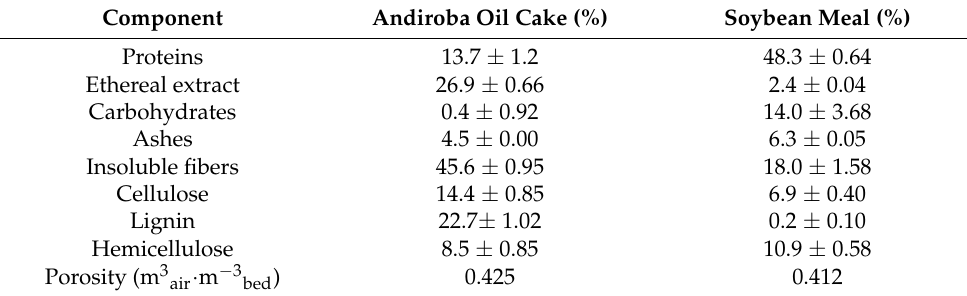
Table 1. Physical-chemical composition of andiroba oil cake and soybean